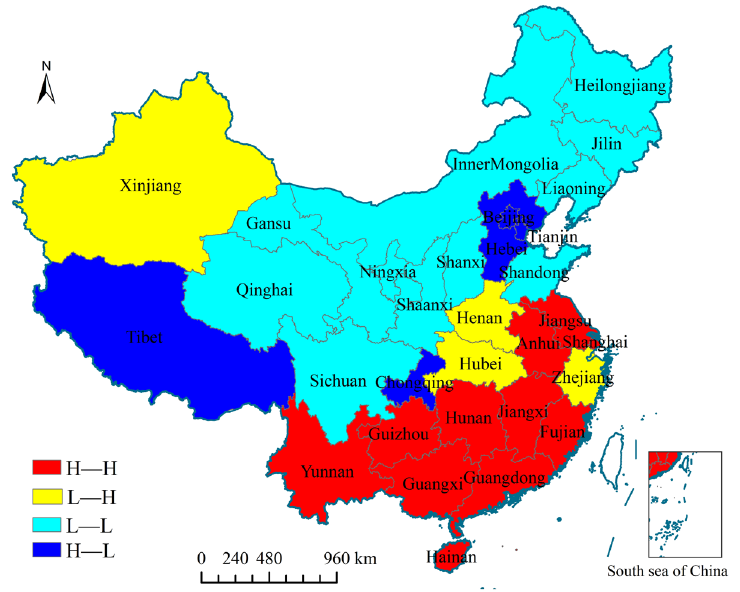
Figure 5. Clustering map of China’s provincial regional forestry ecological efficiency (FEE) in 2018.